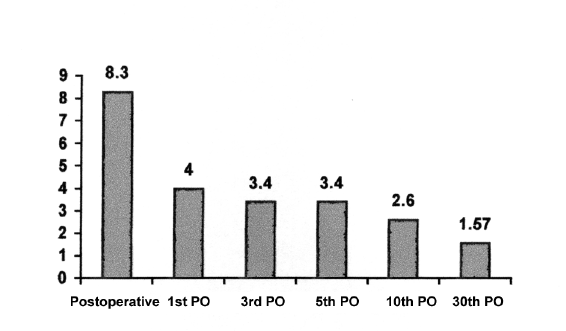
Figure 2 – Evolution of the recipients’ mean serum creatinine, in relation to postoperative days (in